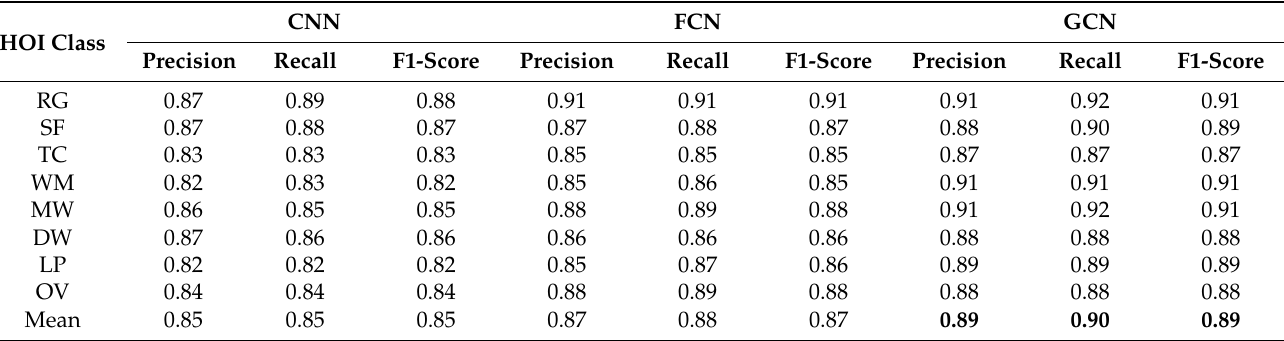
Table 8. Comparison of GCN with CNN and FCN classifiers on D3D HOI dataset in terms of precision, recall and